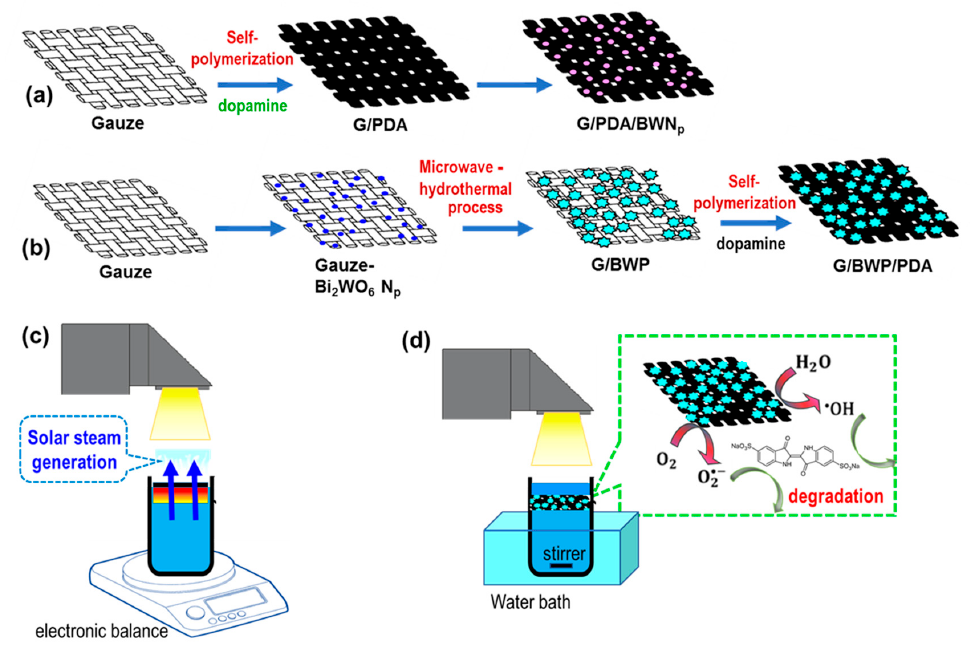
Figure 1. Procedures of the formation of Bi 2 WO 6 -polydopamine decorated gauze ( a ) G/PDA/BWNp (gauze/polydopamine/Bi 2 WO 6 nanoparticles) ( b ) G/BWP/PDA (gauze/Bi 2 WO 6 nanoplates/polydopamine) samples, schematic illustrations of the setup for ( c ) solar steam generation test ( d ) photocatalytic degradation test.